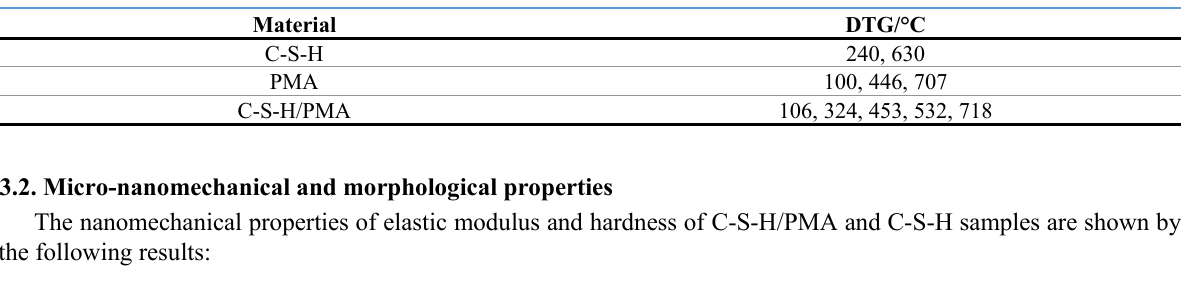
Table 3. Thermogravimetric analysis to C-S-H, PMA and